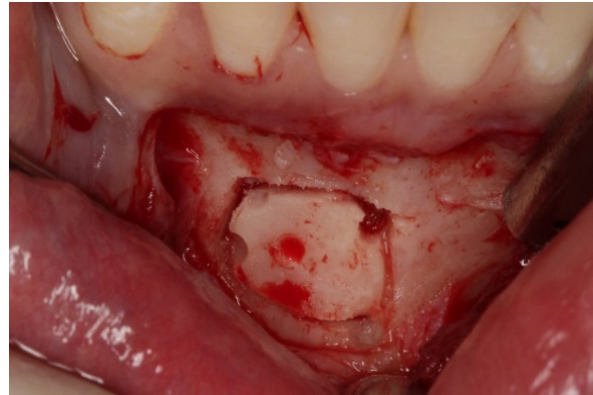
Figure 3. Donor site of the mandible and chin block bone harvesting.